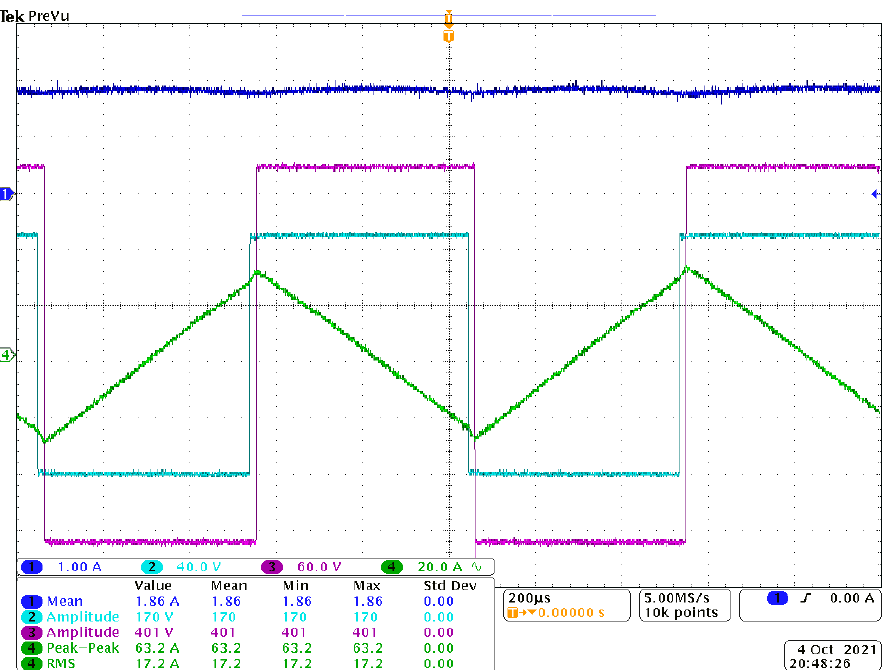
Figure 14. DAB operation at low power under the SPS method.